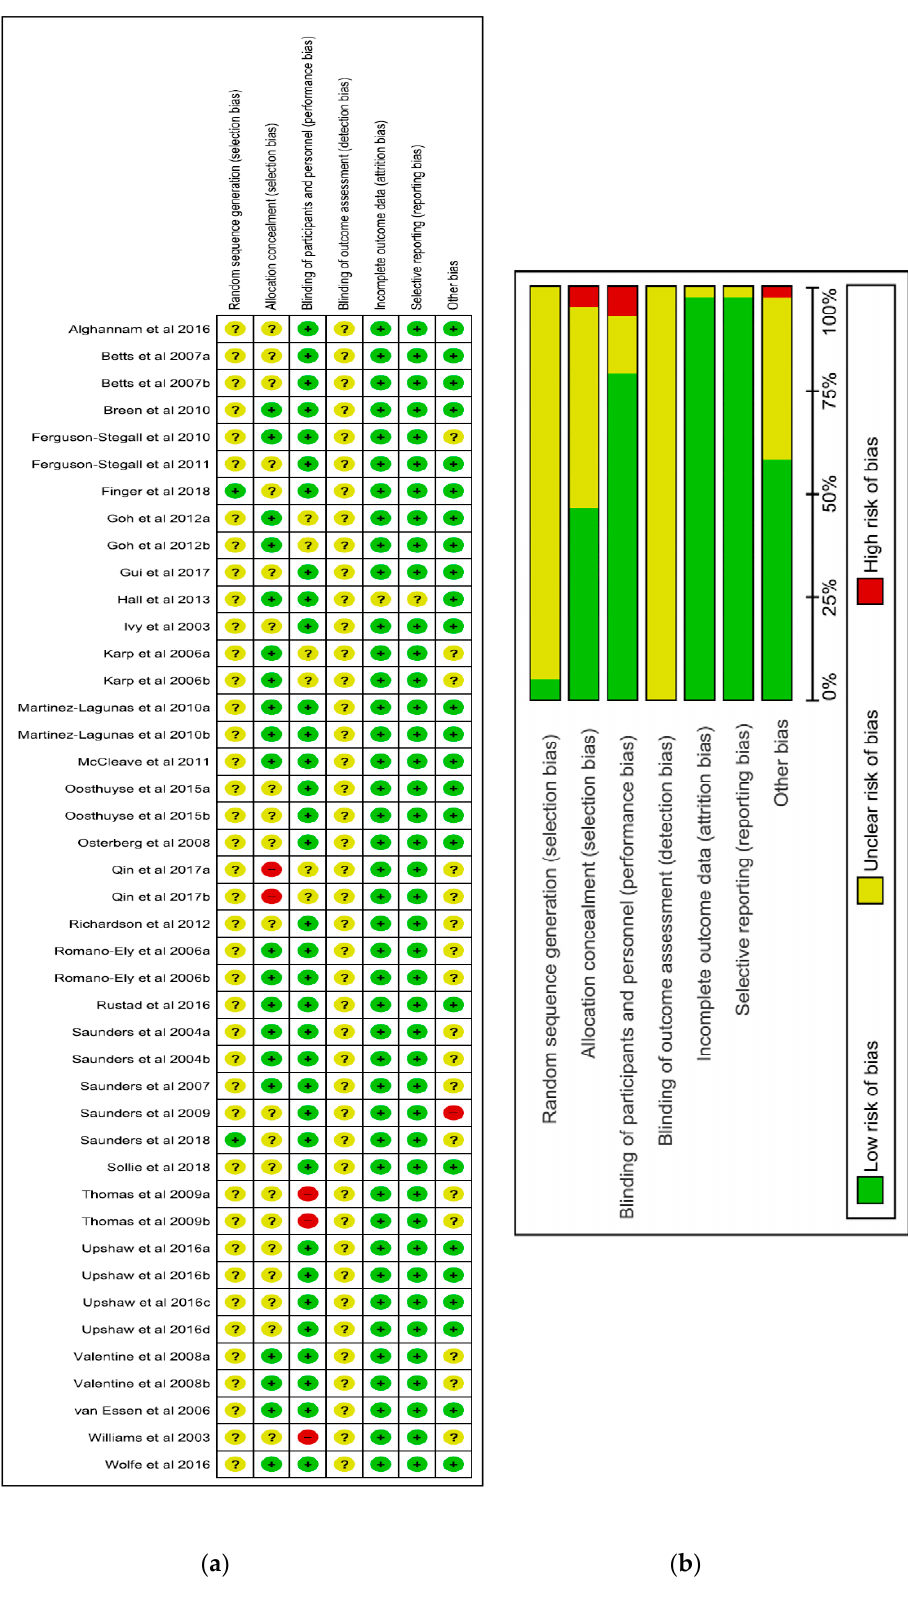
Figure 2. Risk of bias summary of investigations included in meta-analysis. (+): low risk; (?): unknown risk; (-): high risk. ( a ) summarising the risk assessment of each trial. ( b ) illustrating the percentage distribution of the risk assessment.